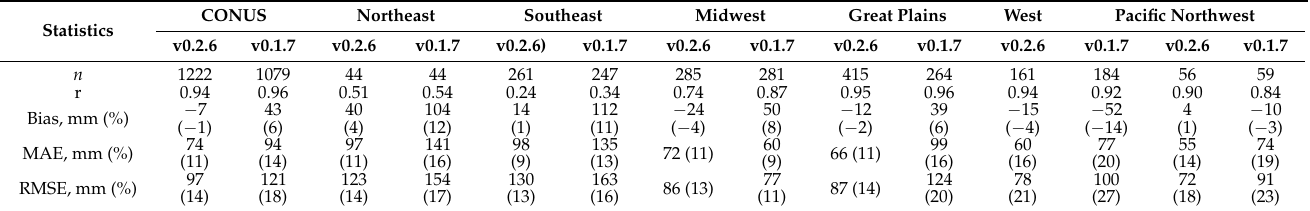
Table 7. Summary of non-matching (different n values) HUC8 ETa comparison between SSEBop v0.1.7 and SSEBop v0.2.6 (FANO) with water balance (WBET) for CONUS and the six regions.